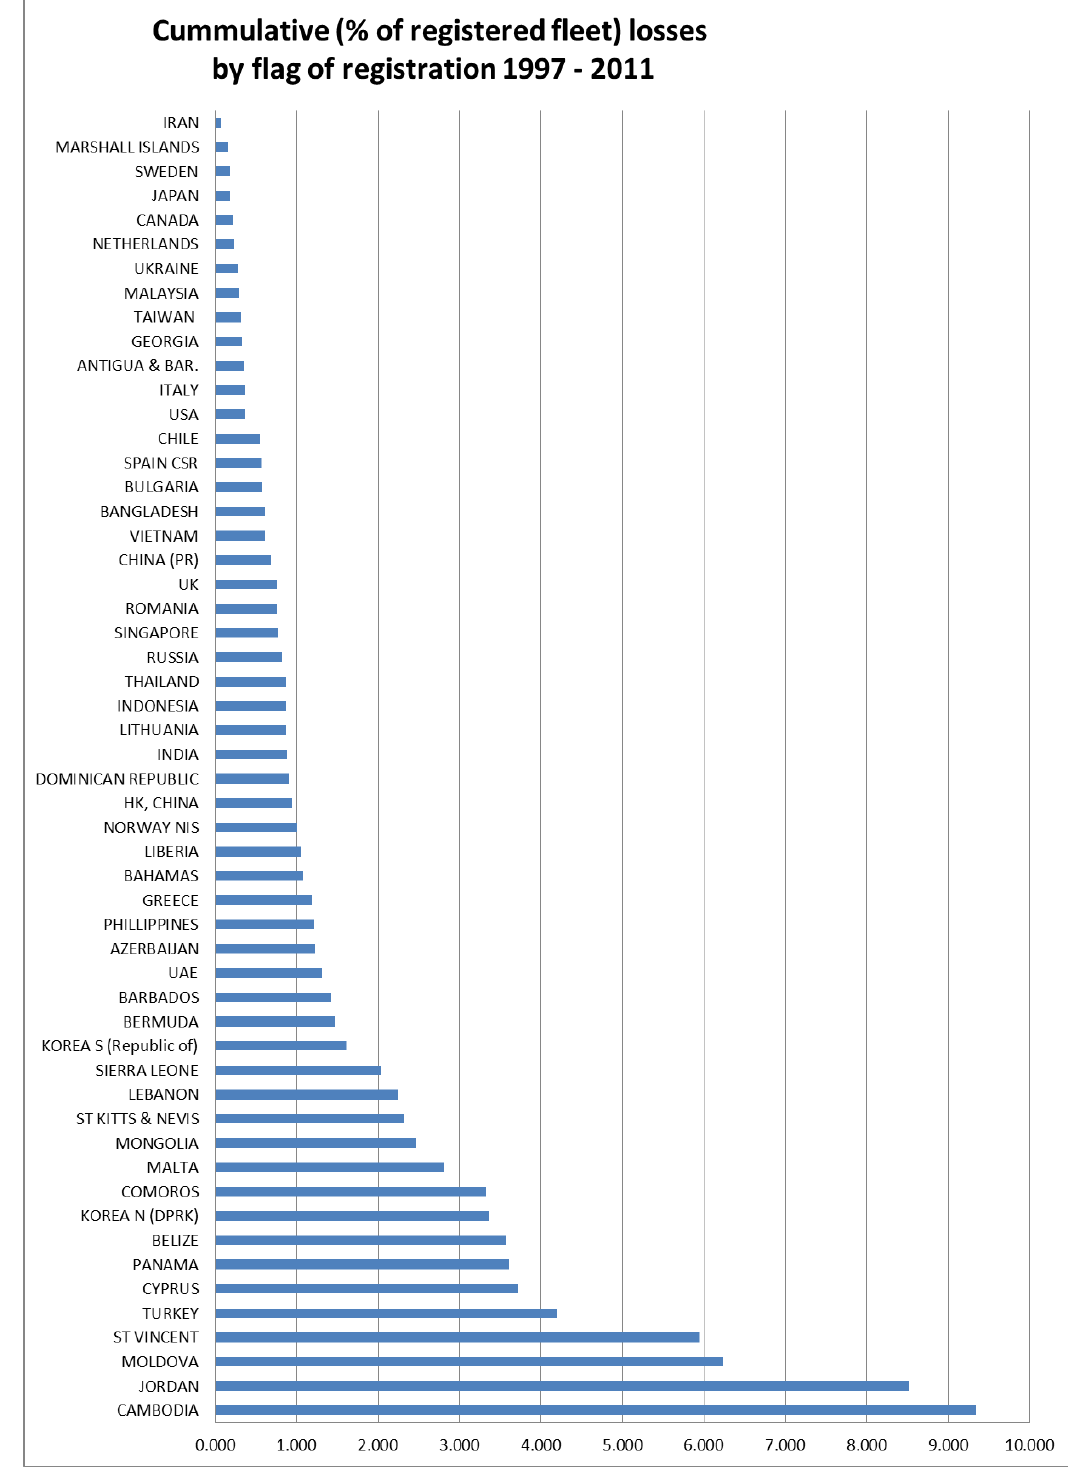
Graph 8: Cumulative losses as a percentage of registered fleet